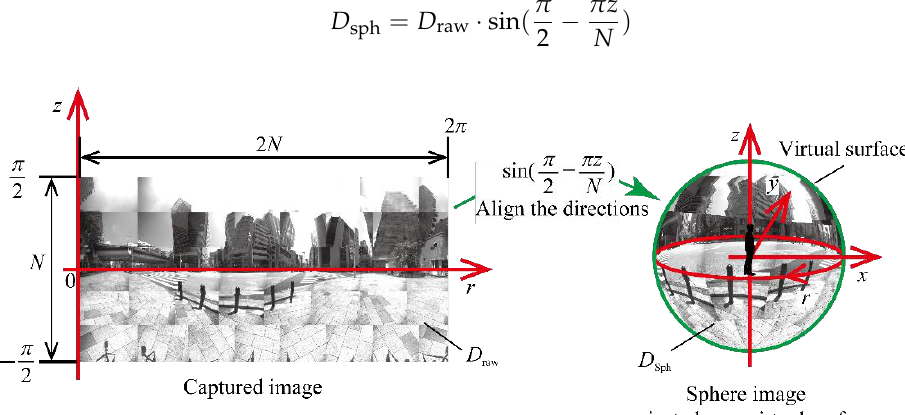
Figure 6. Overview of how to project onto a virtual surface.